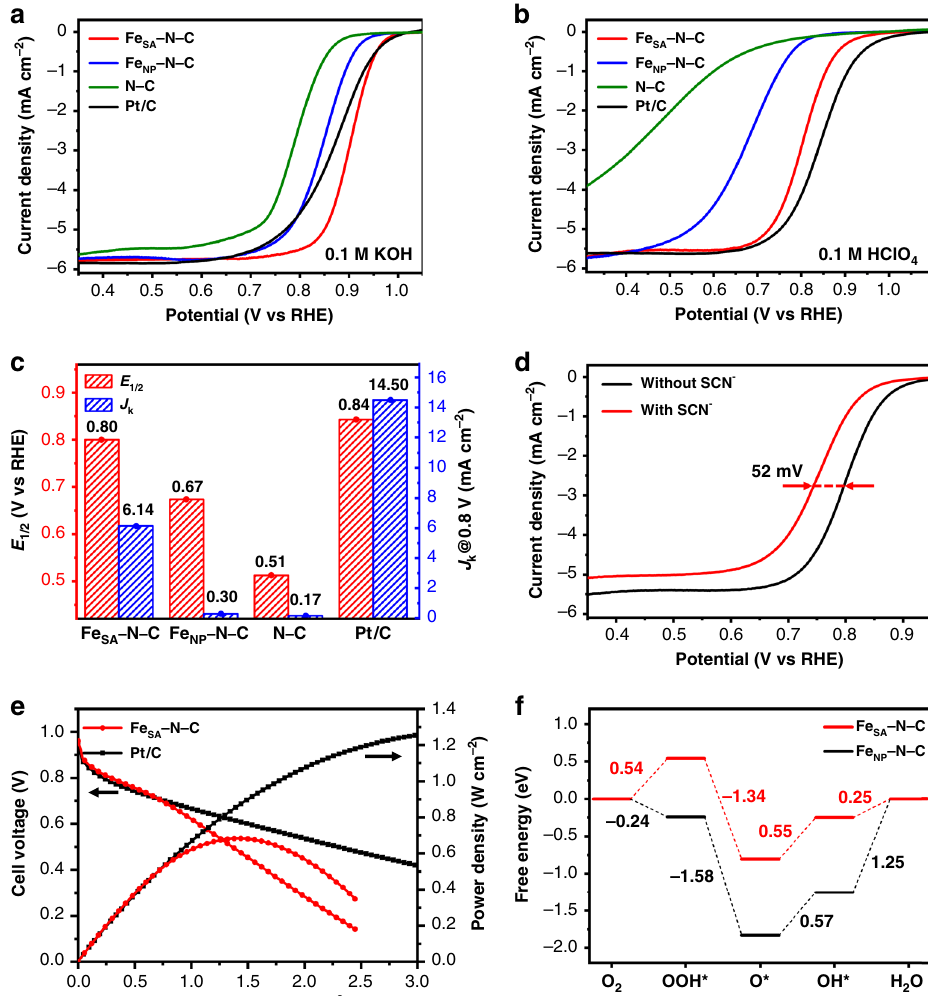
Fig. 4 Electrochemical performances and DFT calculations. LSV curves for Fe SA – N – C (red line), Fe NP – N – C (blue line), N – C (olive line) and Pt/C (black line) in a 0.1 M KOH and b 0.1 M HClO 4 . c Comparison of E 1/2 and J k at 0.80 V for various catalysts in 0.1 M HClO 4 . d LSV curves of Fe SA – N – C in 0.1 M HClO 4 before (black line) and after (red line) the addition of SCN − . e Polarization and power density curves of PEMFCs with Fe SA – N – C (red dots) and Pt/C (black dots) cathode catalysts. f Free energy diagrams of ORR on Fe SA – N – C (red line) and Fe NP – N – C (black line) in acidic media (pH =